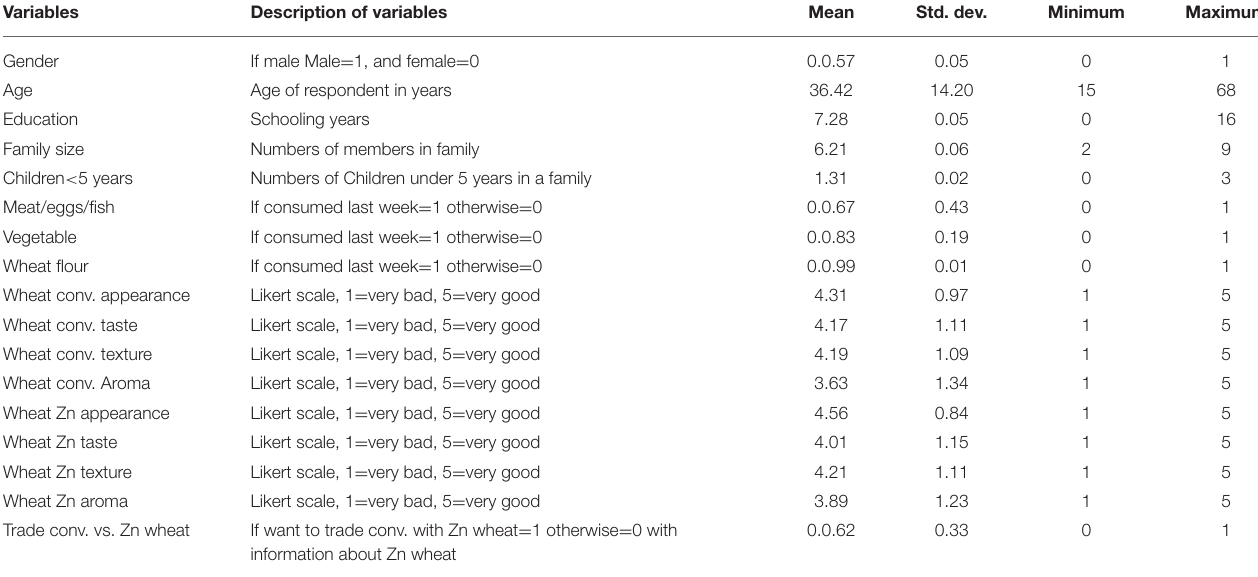
TABLE 1 | Descriptive statistical